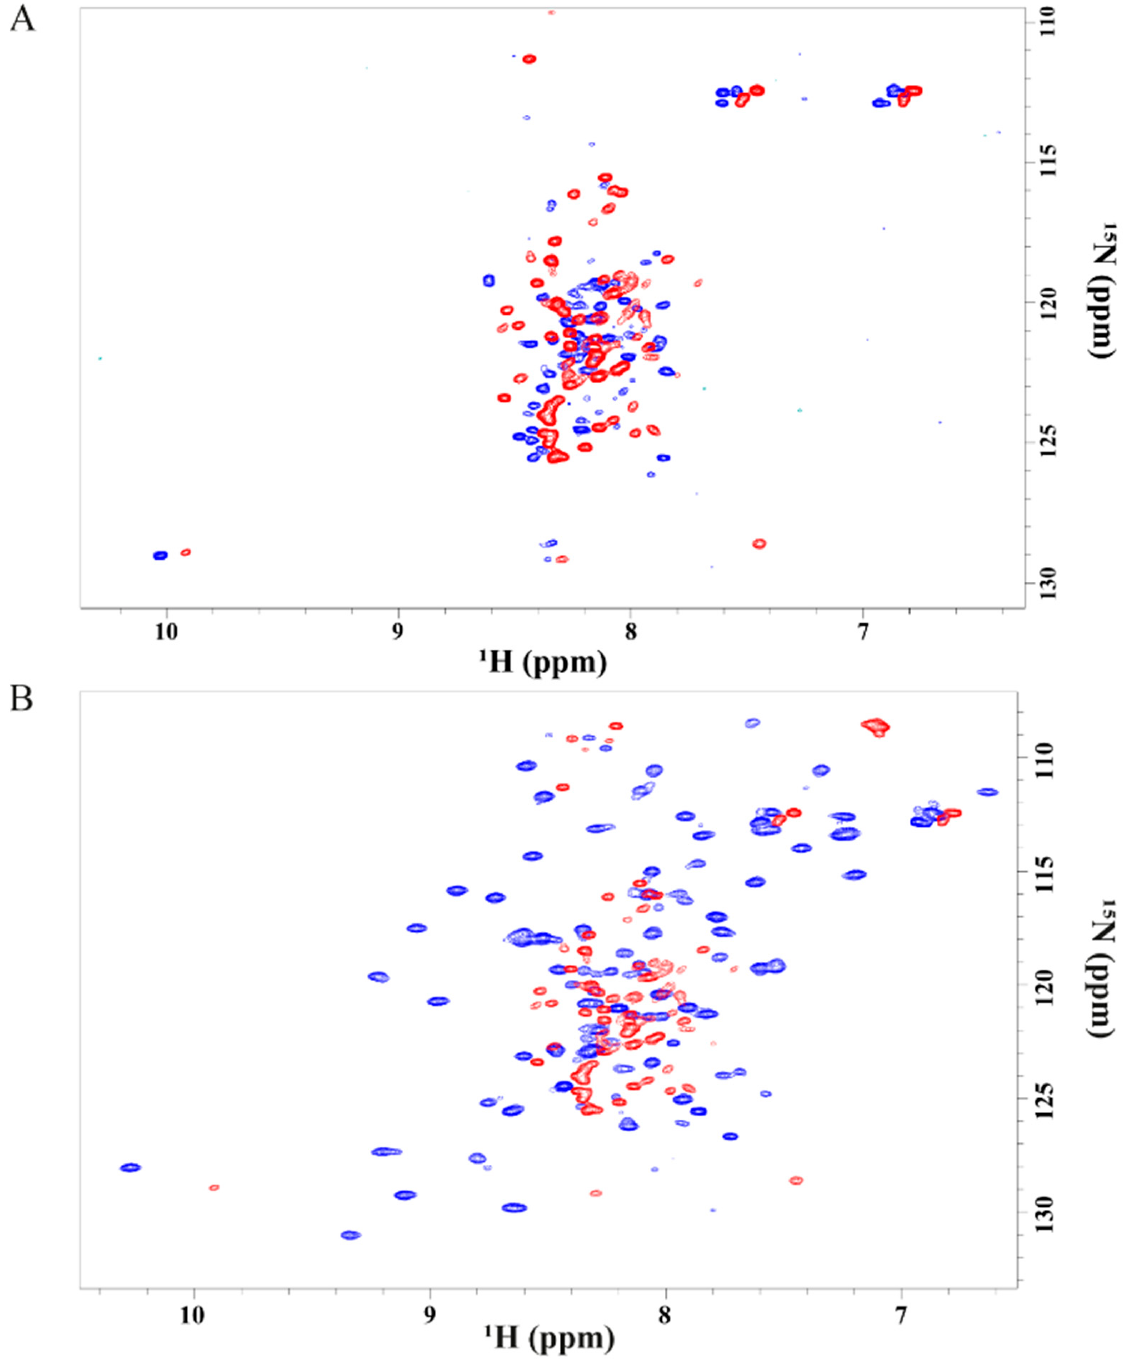
Figure 4. ( A ) Overlay of the 1 H − 15 N HSQC spectrum acquired for Apo-Ros87 (blue) with Cu(I)-Ros87 (red) at 298K. ( B ) Overlay of the 1 H − 15 N HSQC spectrum acquired for Zn-Ros87 (blue) with Cu(I)-Ros87 (red) at 298K.